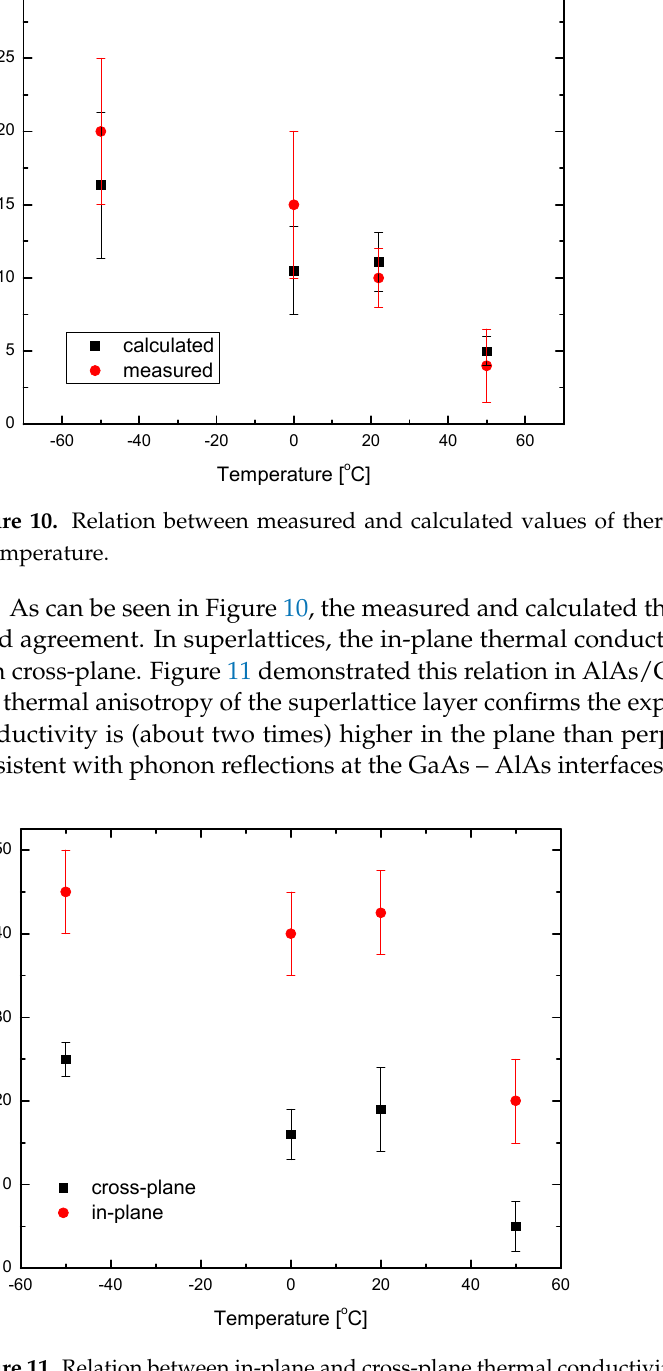
Figure 11. Relation between in-plane and cross-plane thermal conductivity measured for AlAs/GaAs superlattice sample as function of temperature.